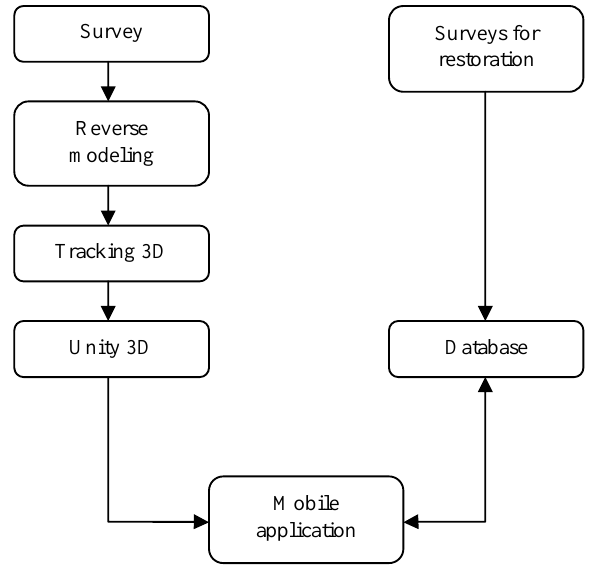
Figure 6. Scheme of the process applied to the creation of the management system